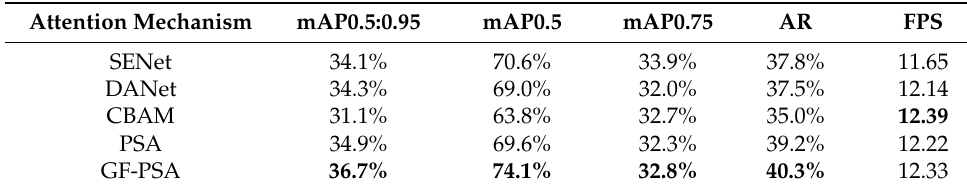
Table 6. Evaluation results of adding different attention mechanisms. The bold numbers represent the highest one of each